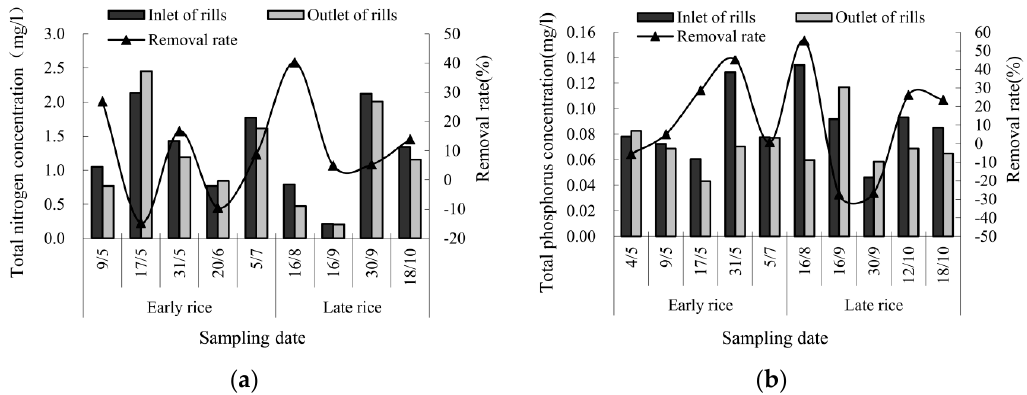
Figure 2. Effect of rill ditch on total nitrogen and total phosphorus removal: ( a ) Reduction of total nitrogen concentration; ( b ) Reduction of total phosphorus concentration. Water 2017 , 9 , 745